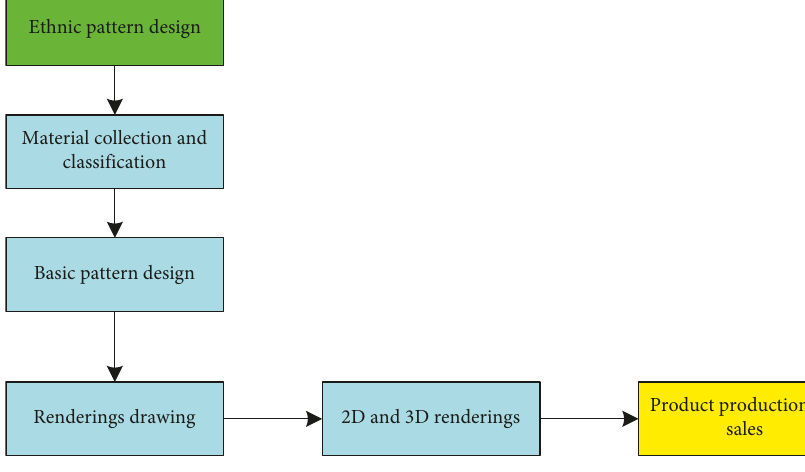
Figure 2: Ethnic clothing pattern